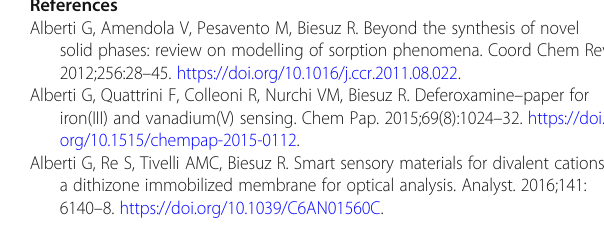
Figure S3. Electronic microscope imagines of the bare Colour Catcher ® at different magnification order Abbreviations EBT: Eriochrome Black T; PAN: 1-(2-Pyridylazo)-2-naphthol; CC: Colour